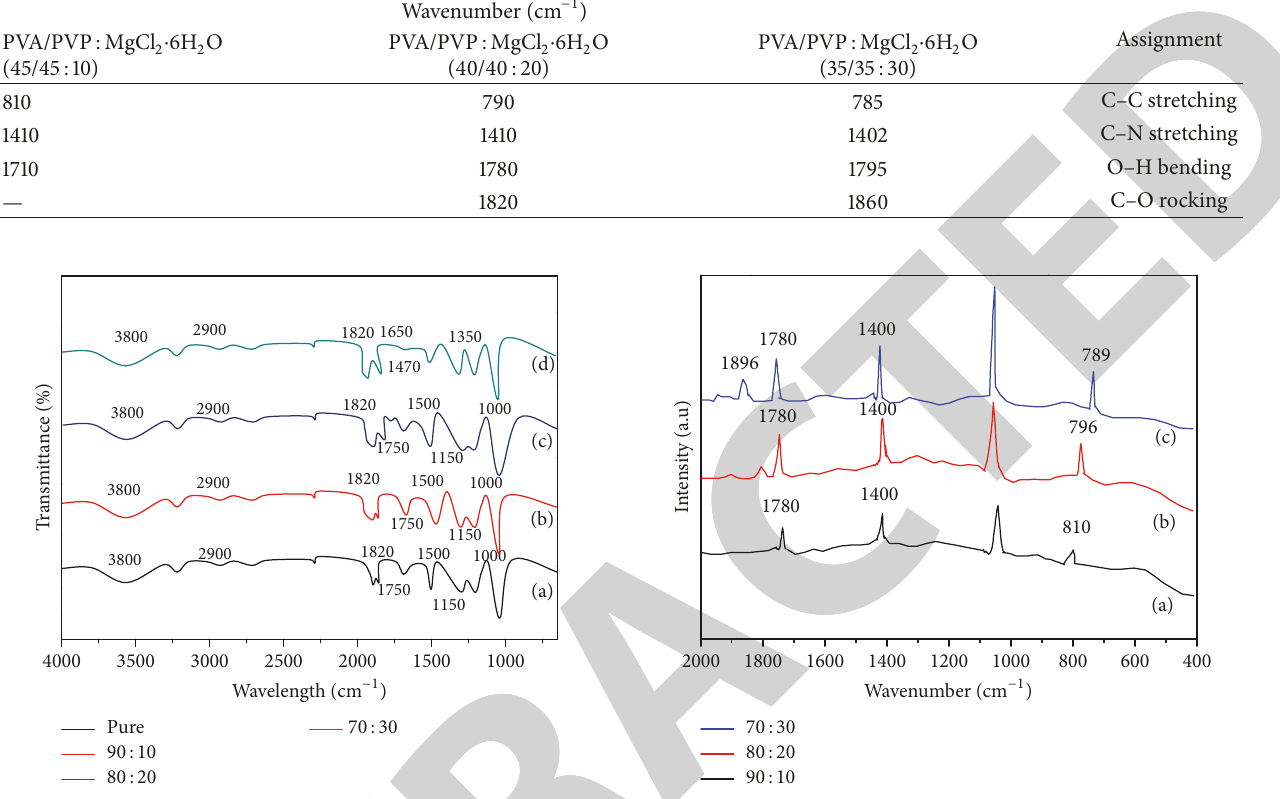
Table 2: Raman bands and wavenumber assignments of polymer electrolyte films for different wt% ratios. Wavenumber (cm −1 )